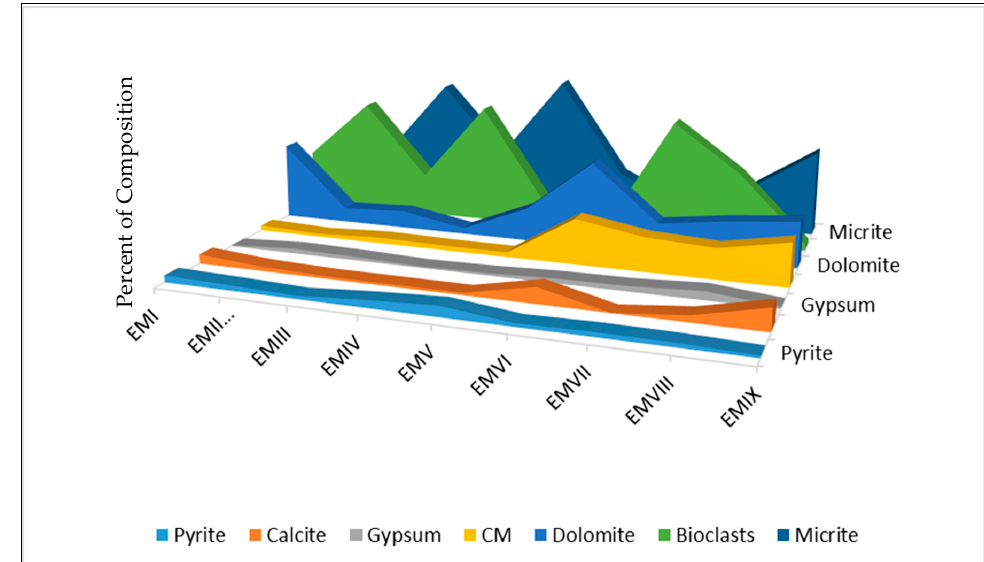
Figure 3. Graphic representation of Table 1. CM, carbonaceous material.